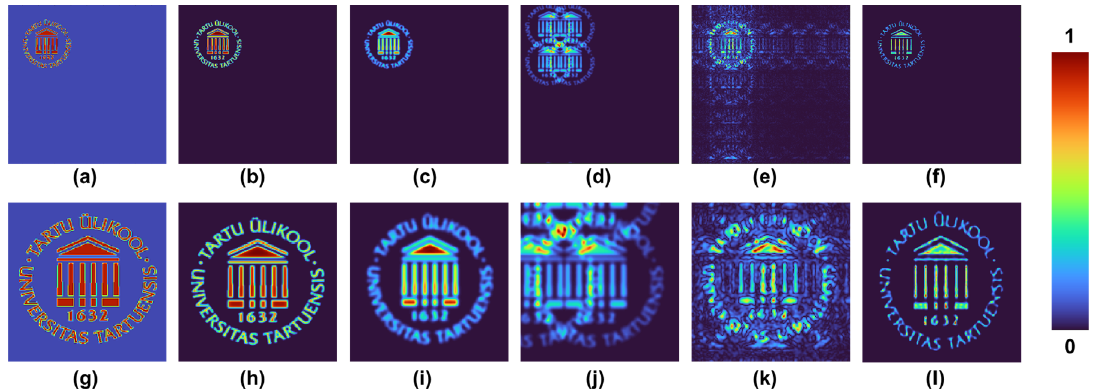
Figure 5. ( a ) Test object and imaging result from ( b ) the ideal diffractive lens, ( c ) the sub-aperture diffractive lens and ( d ) LADISA. Reconstruction results of LADISA using ( e ) NLR and ( f ) LRRA. The magnified versions of the test object in ( a – f ) are shown in ( g – l ), respectively.